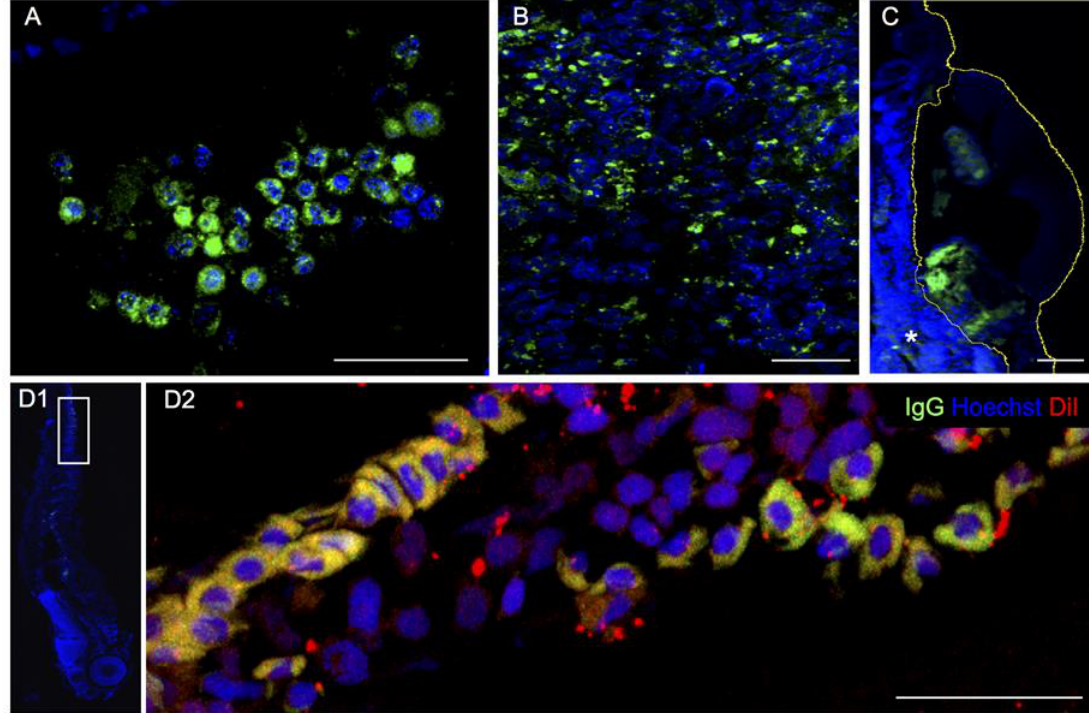
Figure 6. Anti-Human IgG immunohistochemistry (green). ( A ) HCT 116 cancer cell lines two days post injection into the zebrafish yolk. Patient’s pancreatic tumor before ( B ) and after xenotransplantation, 2 dpi ( C ). ( D1 , D2 ) Patient’s colon cancer cells spread throughout the vasculature reaching the zebrafish tail. Human cells are labeled with DiI (red) and anti-IgG (green). D1 is a magnification (90 ◦ rotation) of D2. Scale bar 50 µ m.